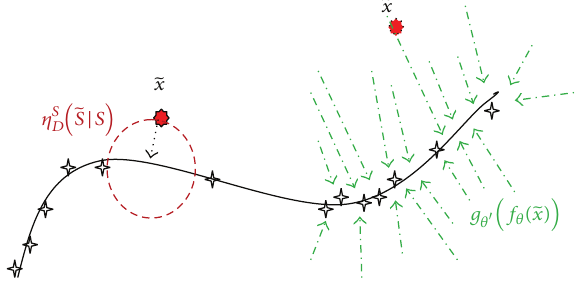
Figure 2: Suppose training data ( ) concentrate near a low- dimensional manifold. Corrupted examples ( ) obtained by apply- (̃𝑆 | 𝑆) will lie farther from the manifold. ing corruption process 𝜂 𝑆 𝐷 ̃𝑋) to “project them back” The model learns 𝑔 𝜃 󸀠 (𝑓 𝜃 (̃𝑥)) with 𝑃(𝑋 | onto the manifold.